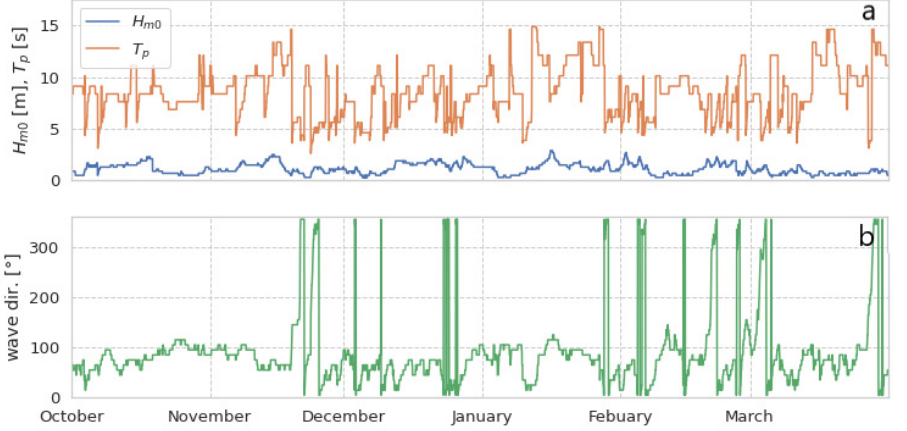
Figure 6. Realization of the Markov chain model for VB. ( a ) Zero-moment wave height (blue line) and peak period (orange line); ( b ) wave direction (green line).